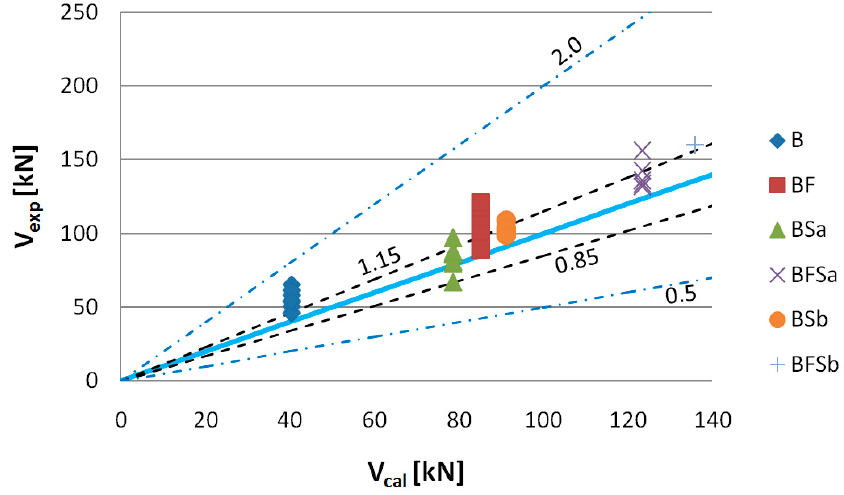
Figure 23. Values of experimentally fixed ( V exp ) versus computational ( V cal ) shear capacity deter- mined according to the former method Model Code 2010 ( θ = 30°).